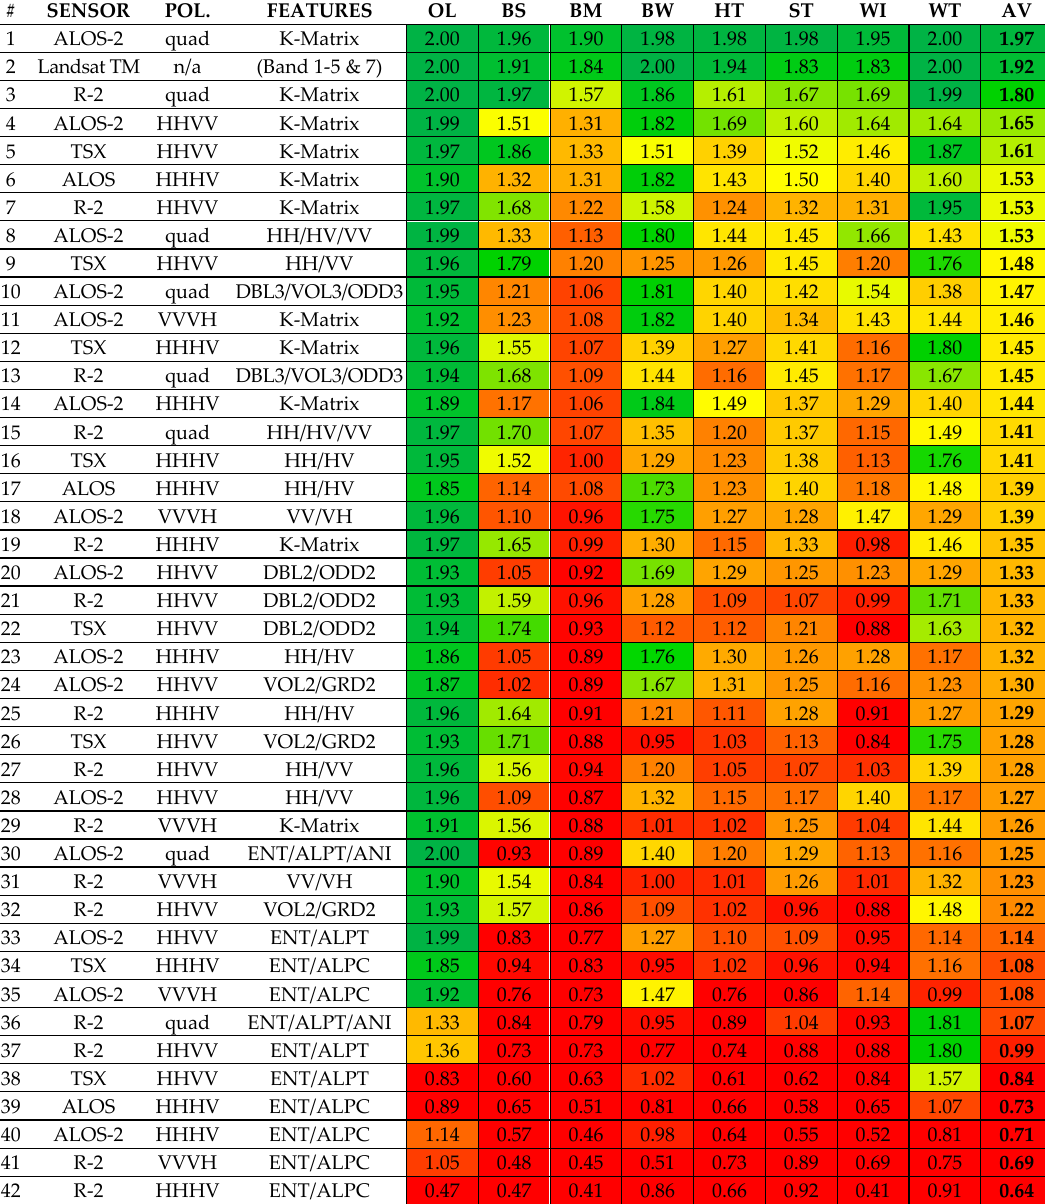
Table 5. Average class separability measured as squared Jefferys Matusita Distance (JD) for classes OL (Permanent Water Bodies), BS (Sand), BM (Mixed Sediment), BW (Driftwood Accumulation), HT (Herb Dominated Tundra), ST (Shrub Dominated Tundra), WI (Inundated Low Lying Tundra) and WT (Wetland) (see Table 2). JD is ranging from 0 to 2; higher values indicate better class separation. The feature spaces are ranked in descending order of the average separability (AV). The black bars are scaled linearly between the minimum and maximum of AV. The colors from red to yellow to green correspond to the 10%, 50% and 90% quantiles of the AV.